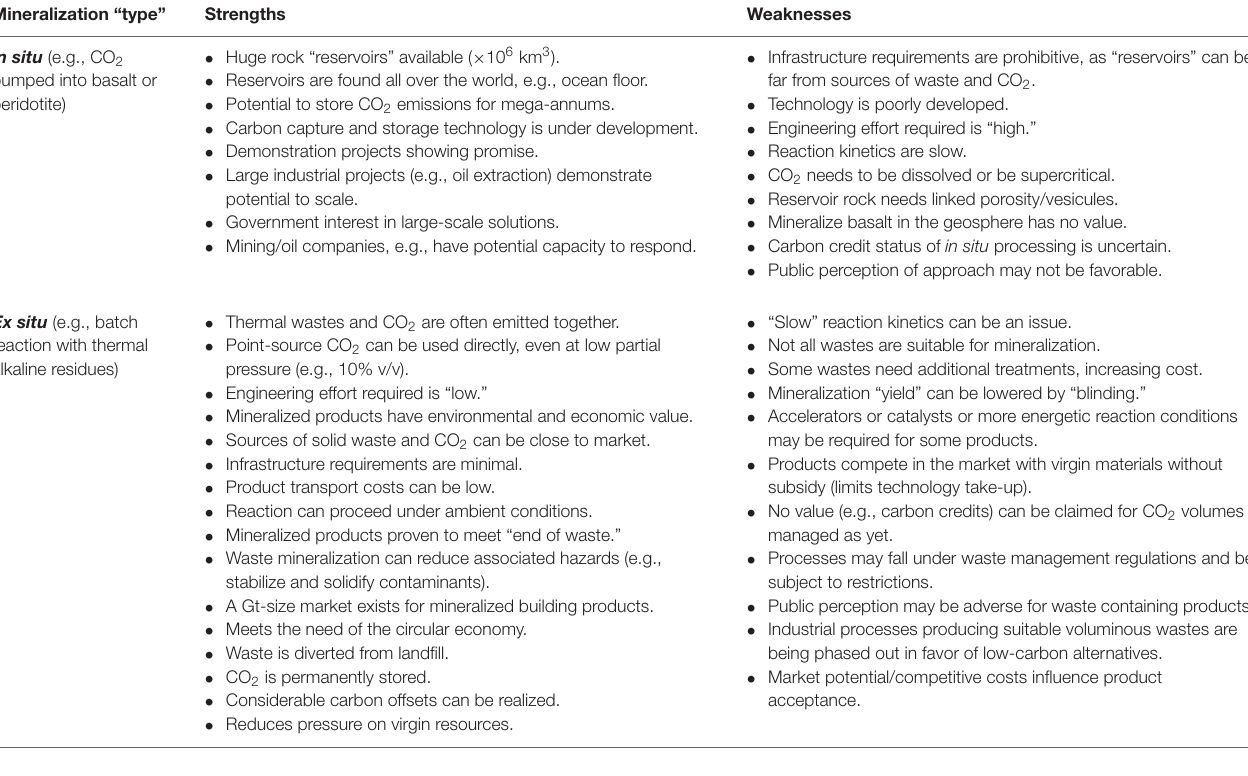
TABLE 2 | Example strengths and weaknesses of mineralization technologies. Mineralization “type” Strengths Weaknesses